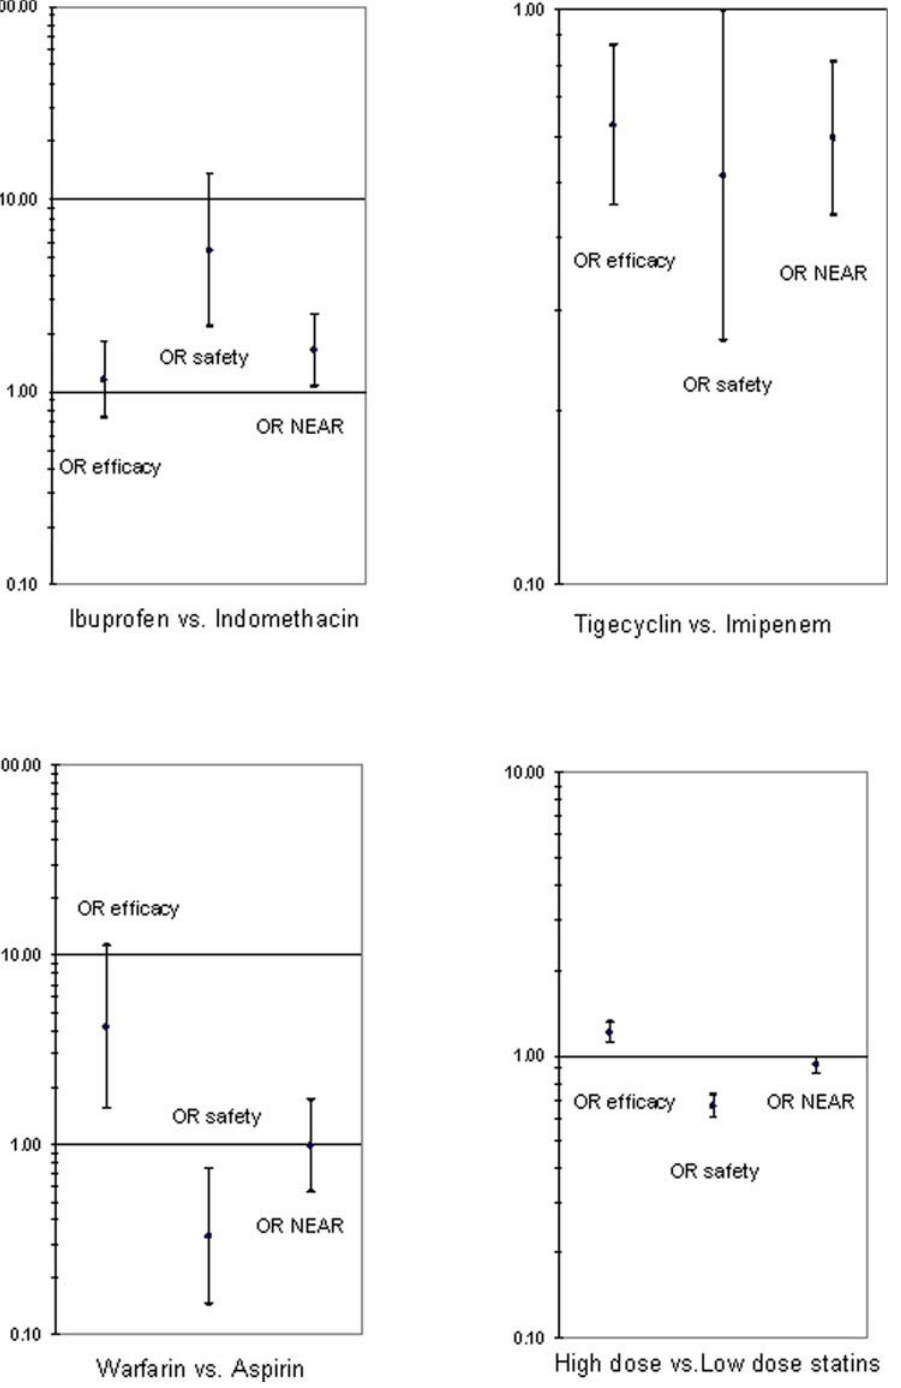
Figure 1. Graphic representation of traditional efficacy and safety odds ratio (OR) together with the OR for ‘‘net efficacy adjusted for adverse reactions’’ (NEAR ). Data were extracted from trials comparing ibuprofen vs. indomethacin for the closure of patent ductus arteriosus [7]; tigecycline versus imipenem/cilastatin in patients with complicated intra-abdominal infections [11]; warfarin vs. aspirin for preventing thromboembolic events in patients suffering atrial fibrillation [12] and moreintensive vs. less intensive statin therapy in cardiovasculardiseases [13]. When the lower limit of the 95% confidence interval is above 1.0, the proband drug (first-mentioned in graphic footnotes) is better than the control one.